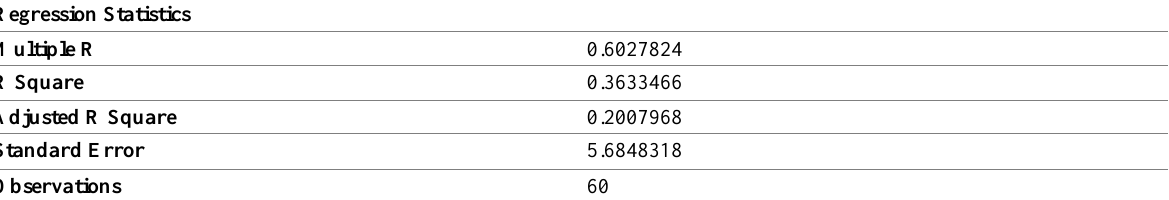
Table 13: Regression Statistics (Khulna Division)